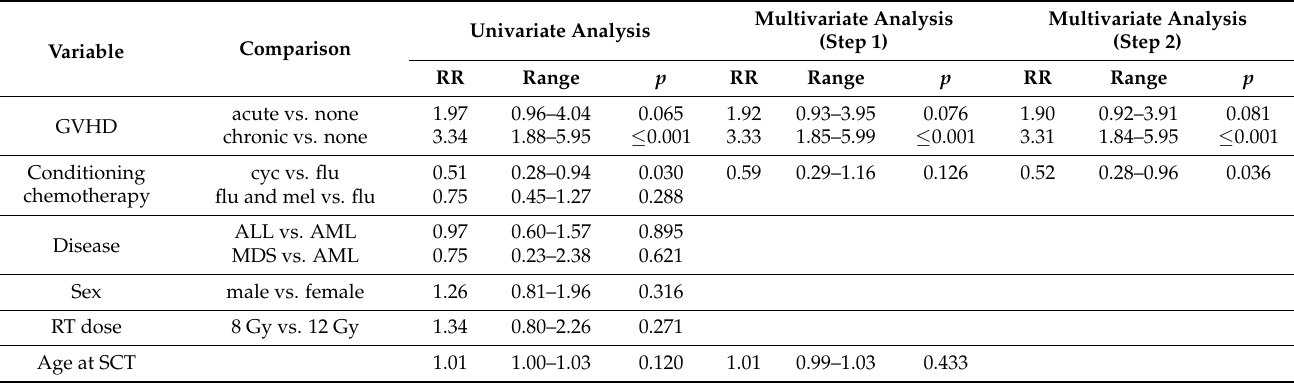
Figure 1. Pulmonary toxicity-free survival (PTFS). ( a ) Kaplan–Meier curve of the whole collective. ( b ) PTFS dependence on occurrence of graft-versus-host-disease (GVHD) for patients suffering from acute (blue), chronic (green) or no (red) GVHD. There was a significant difference in mean PTFS with 141.4 m for acute GVHD, 131.1 m for chronic GVHD and 183.3 m for absence of GVHD ( p < 0.001), respectively. ( c ) PTFS dependence on the use of total body irradiation (TBI) radiation dose: PTFS percentage for patients treated with 8 (blue) or 12 Gy (green) TBI. There was no significant difference in PTFS ( p = 0.268). Table 4. Overview on relative risk according to univariate and multivariate analyses. Values of relative risk were rounded to two decimal places. ALL: acute lymphoid leukemia; AML: acute myeloid leukemia; cyc: cyclophosphamide; flu: fludarabine; GVHD: graft-versus-host-disease; Gy: Gray; mel: melphalan; MDS: myelodysplastic syndrome; RR: relative risk; RT: radiotherapy; SCT: stem cell